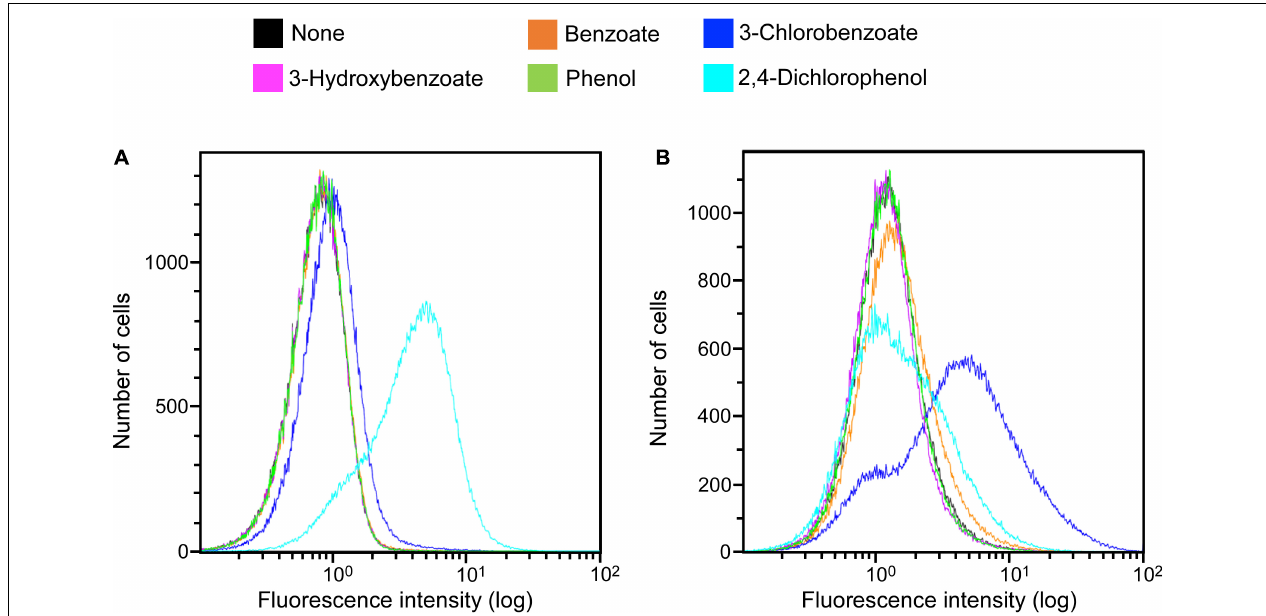
FIGURE 3 | Clone expression histograms of Evoglow. The clone was isolated from the KY11-E06_0–5 library after induction with 3-chlorobenzoate under anaerobic conditions. Histograms of fluorescence of 2.00 × 10 5 cells were obtained using Gallios flow cytometer after cell exposure to the indicated compounds. The fluorescence intensity (log) was displayed up to 1.00 × 10 2 . (A) Aerobic conditions; (B) anaerobic conditions.